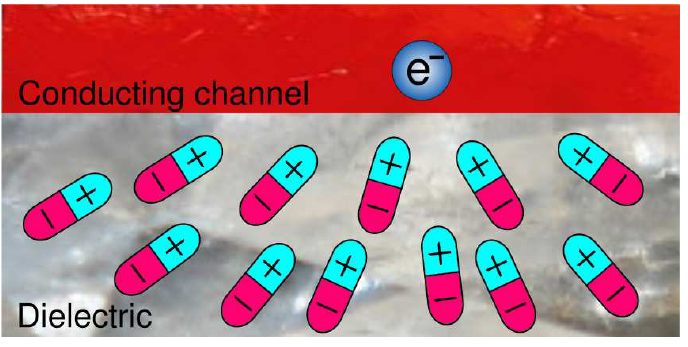
Figure 8. Sketch of the effects induced by the charge carrier in the conducting channel on the gate close to the interface. The electron in the organic semiconductor induces a polarization within the dielectric that, in turn, affects the electron